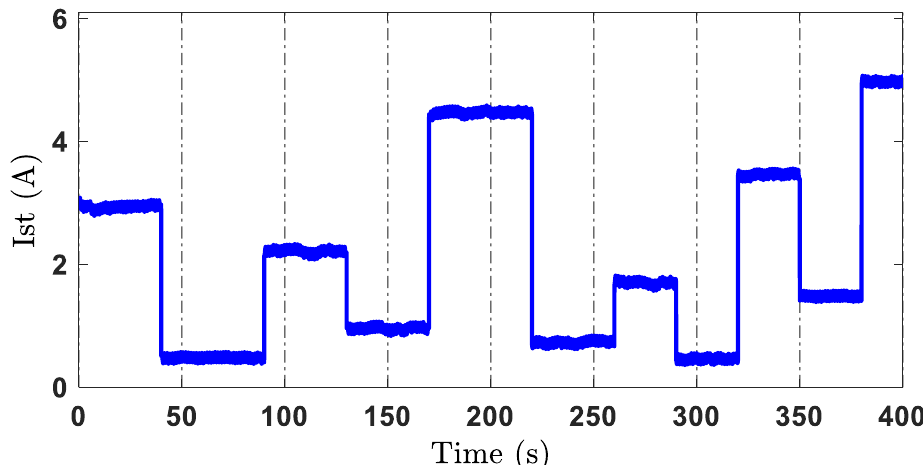
Figure 9. Multistep load current in the experiment.